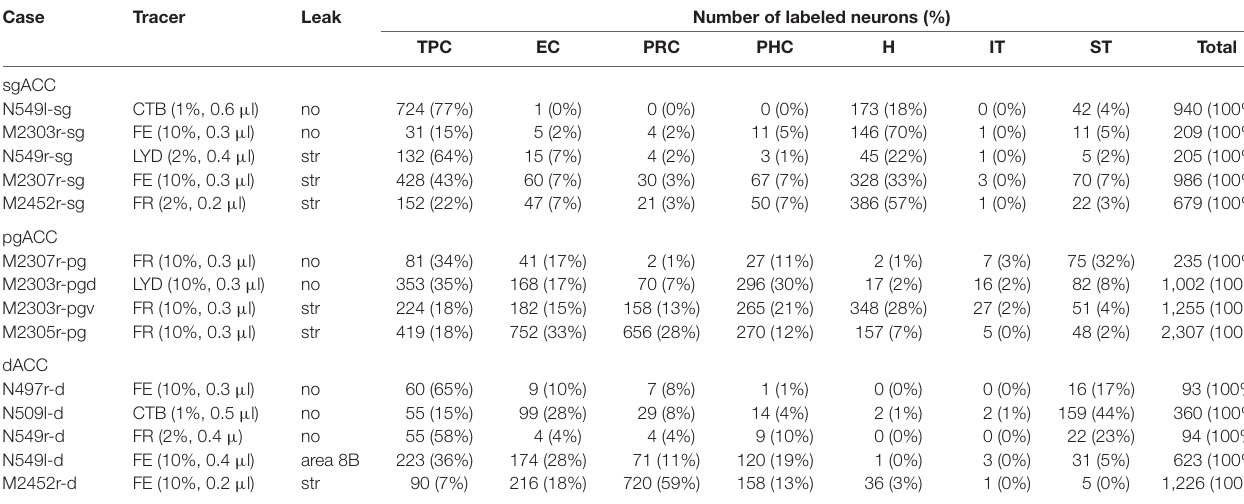
TABLE 1 | Number of labeled neurons in the temporal areas. Case